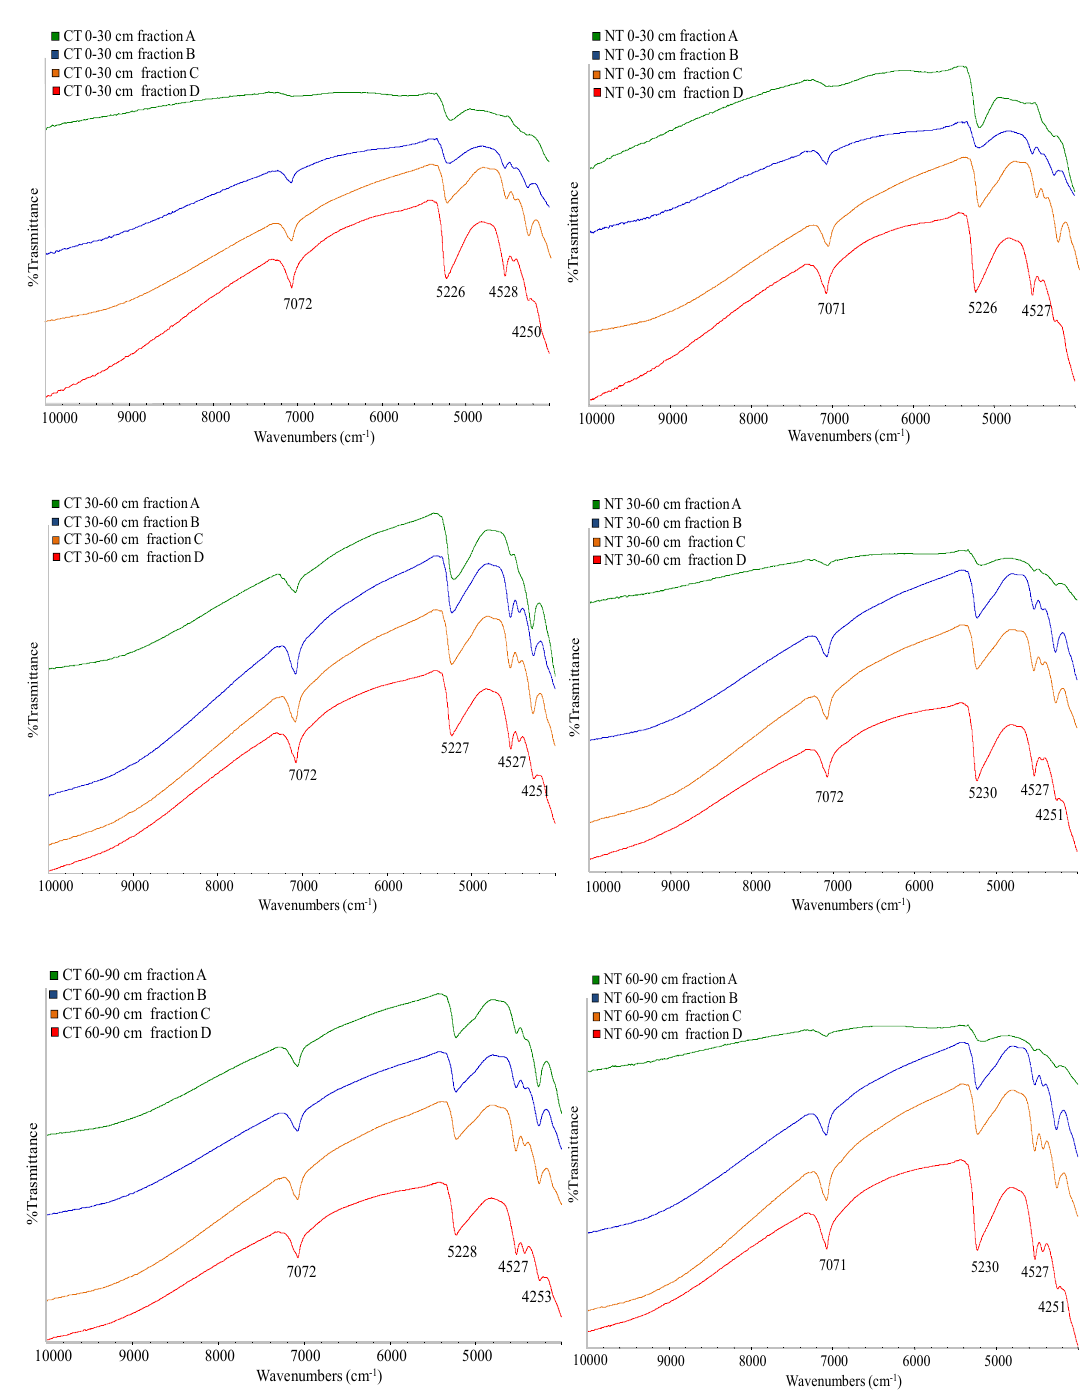
Figure 2. Near infrared reflectance (NIR) spectra of all soil fractions isolated from different tillage treatments at three soil depths. The analysis of variance and mean values of amorphous oxides subdivided by soil depth, size fractions (C and D) and tillage are reported in Table 3.